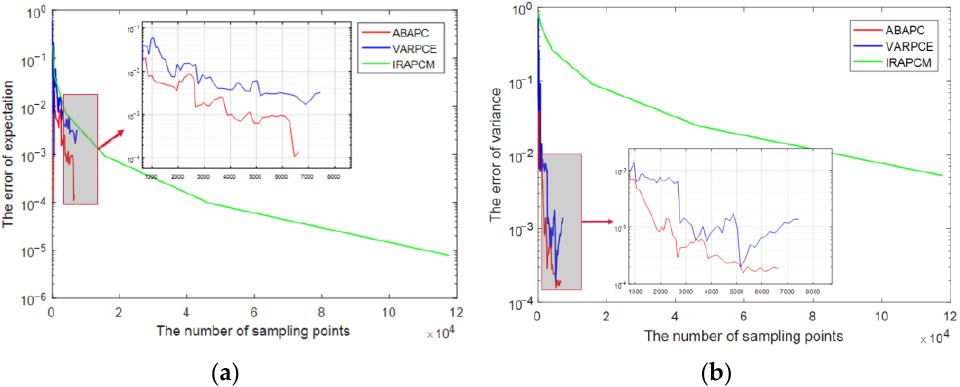
e r e r Figure 2. Convergence of er µ and er σ for case 1 using different methods: ( a ) relative error of Figure 2. Convergence of for case 1 using different methods: ( a ) relative error of  and  expectations, and ( b ) relative error of expectations, and ( b ) relative error of variances.